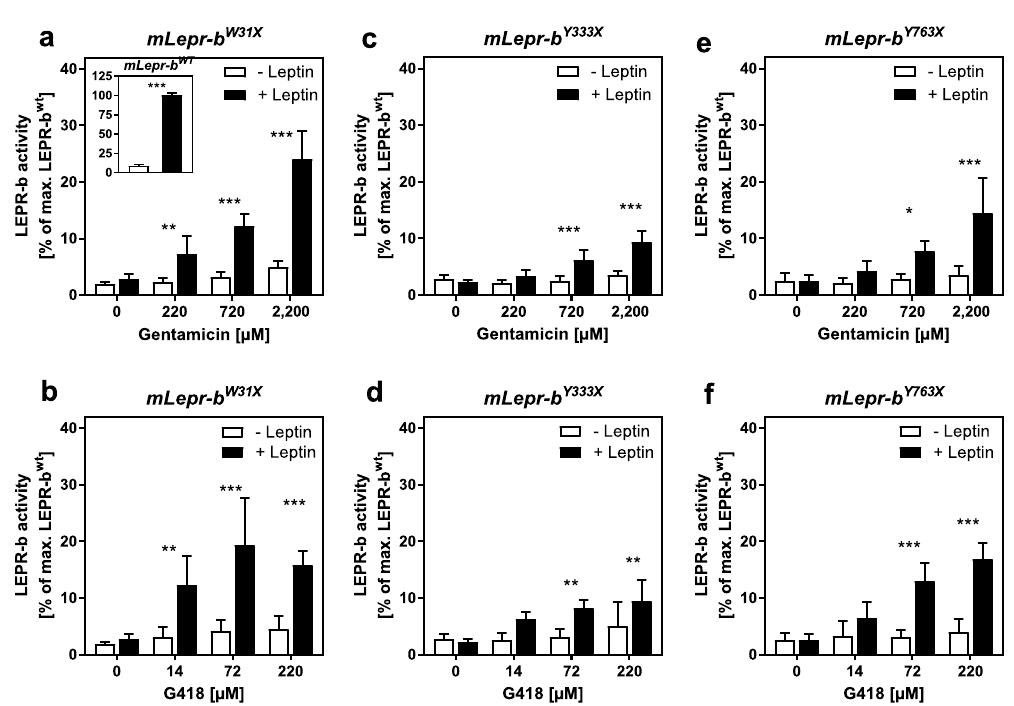
Figure 2. Aminoglycoside mediated rescue of signalling properties of nonsense mutated LEPR-b variants. HEK293 cells were co-transfected with either ( a , b ) mLepr - b W31X - (inset mLepr - b wt ), ( c , d ) mLepr - b Y333X - or ( e , f ) mLepr - b Y763X -pcDNA3.1 overexpression construct, STAT3-RE-PLuc and phRG-b. Two days after the transfection, cells were treated for 24 h with different concentrations of the aminoglycosides and for the last 16 h in addition with 6 nM murine leptin (n = 4, SD). Statistical significance between ( − ) and ( + ) leptin was assessed by t-tests with Bonferroni-Holm correction for multiple comparisons * p < 0.05; ** p < 0.01; *** p <